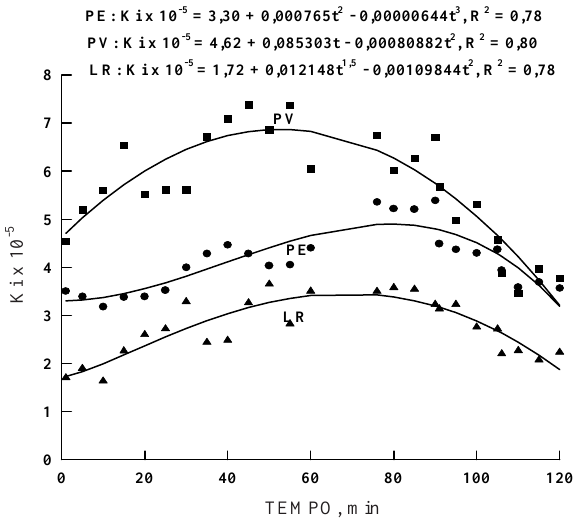
Figura 1. Curvas de erodibilidade entressulcos (Ki) versus o tempo (t) de aplicação das chuvas para o PE, PV e